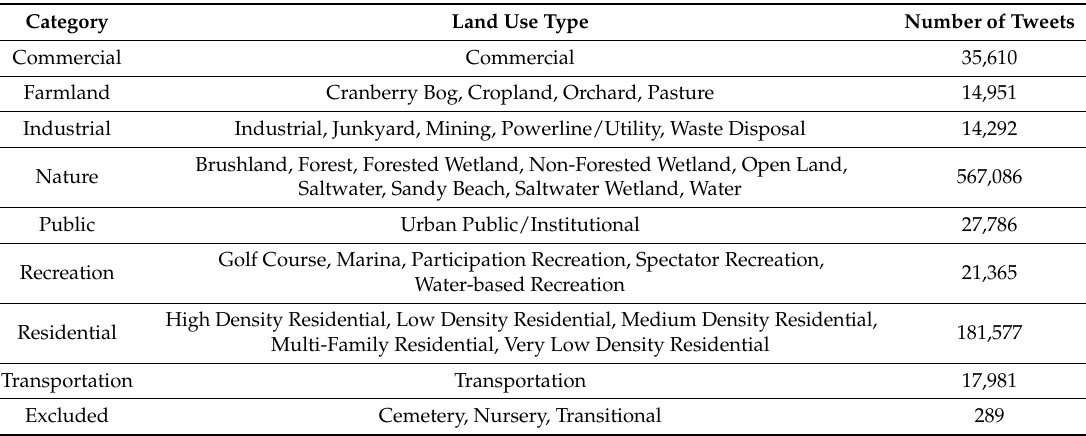
Figure 1. Geographical distribution of 33 land use types within MA (mapping based on the MassGIS land use data [44]). Table 1. Classification of land use in MA.